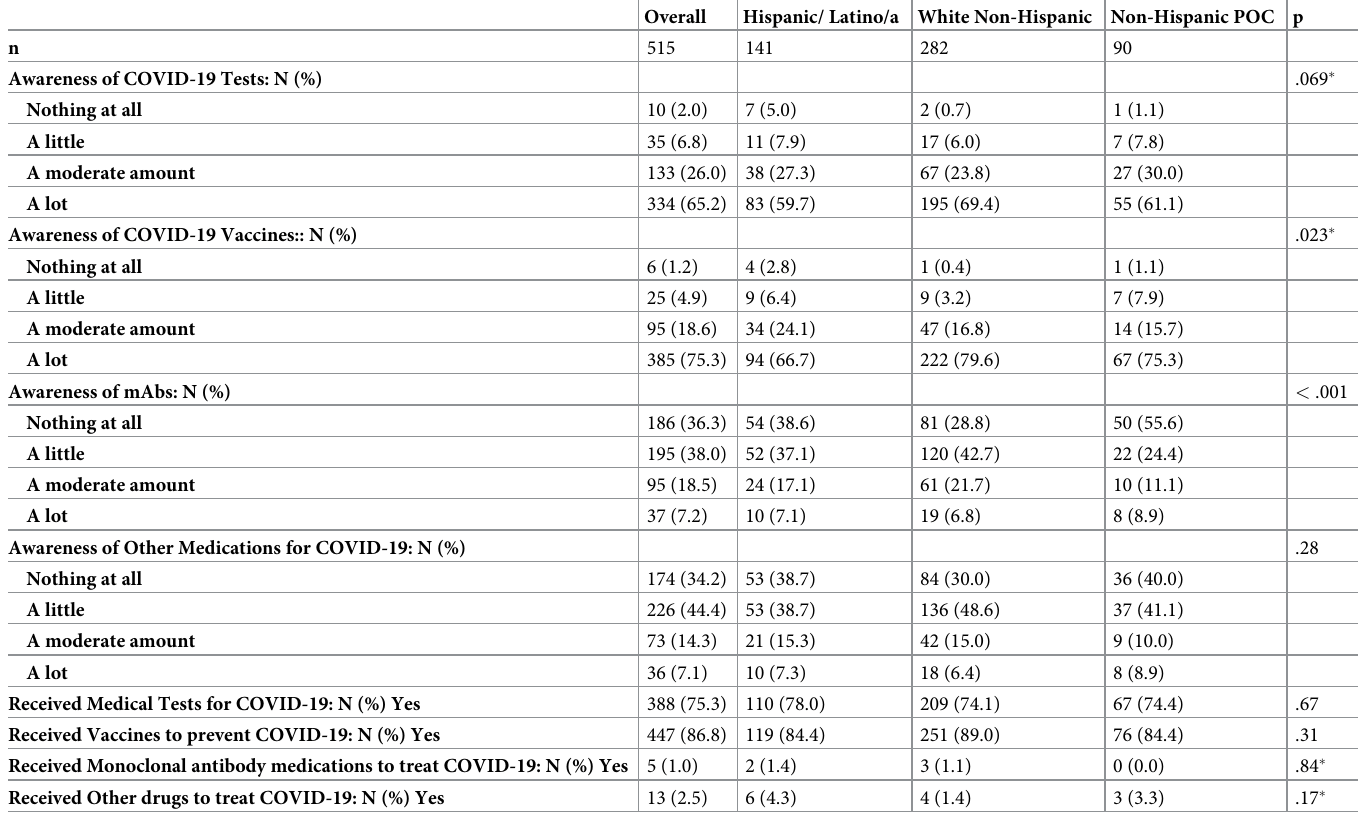
Table 2. Awareness of and experience with tests, vaccines, and treatments for COVID-19 by Race/Ethnicity. Overall Hispanic/ Latino/a White Non-Hispanic Non-Hispanic POC p n 515 141 282